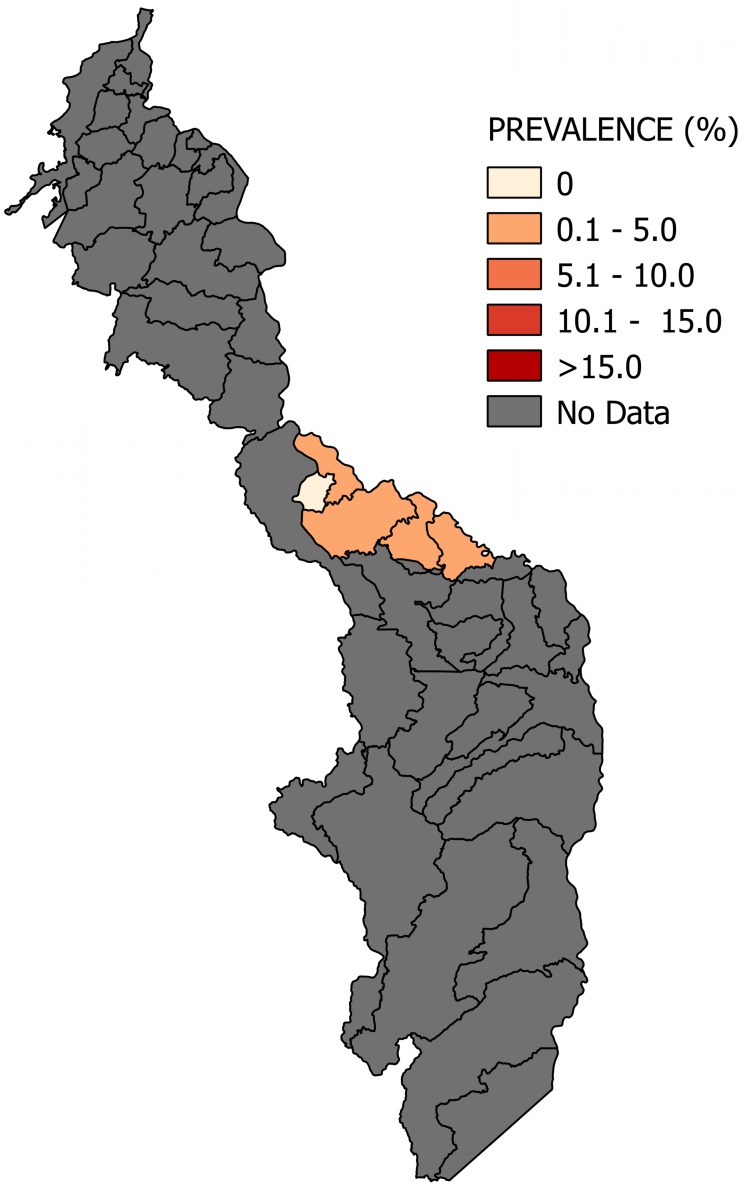
Map of the municipalities of Bolívar showing the distribution of observed Chagas disease prevalence in studies published from 2007 to November 2017.